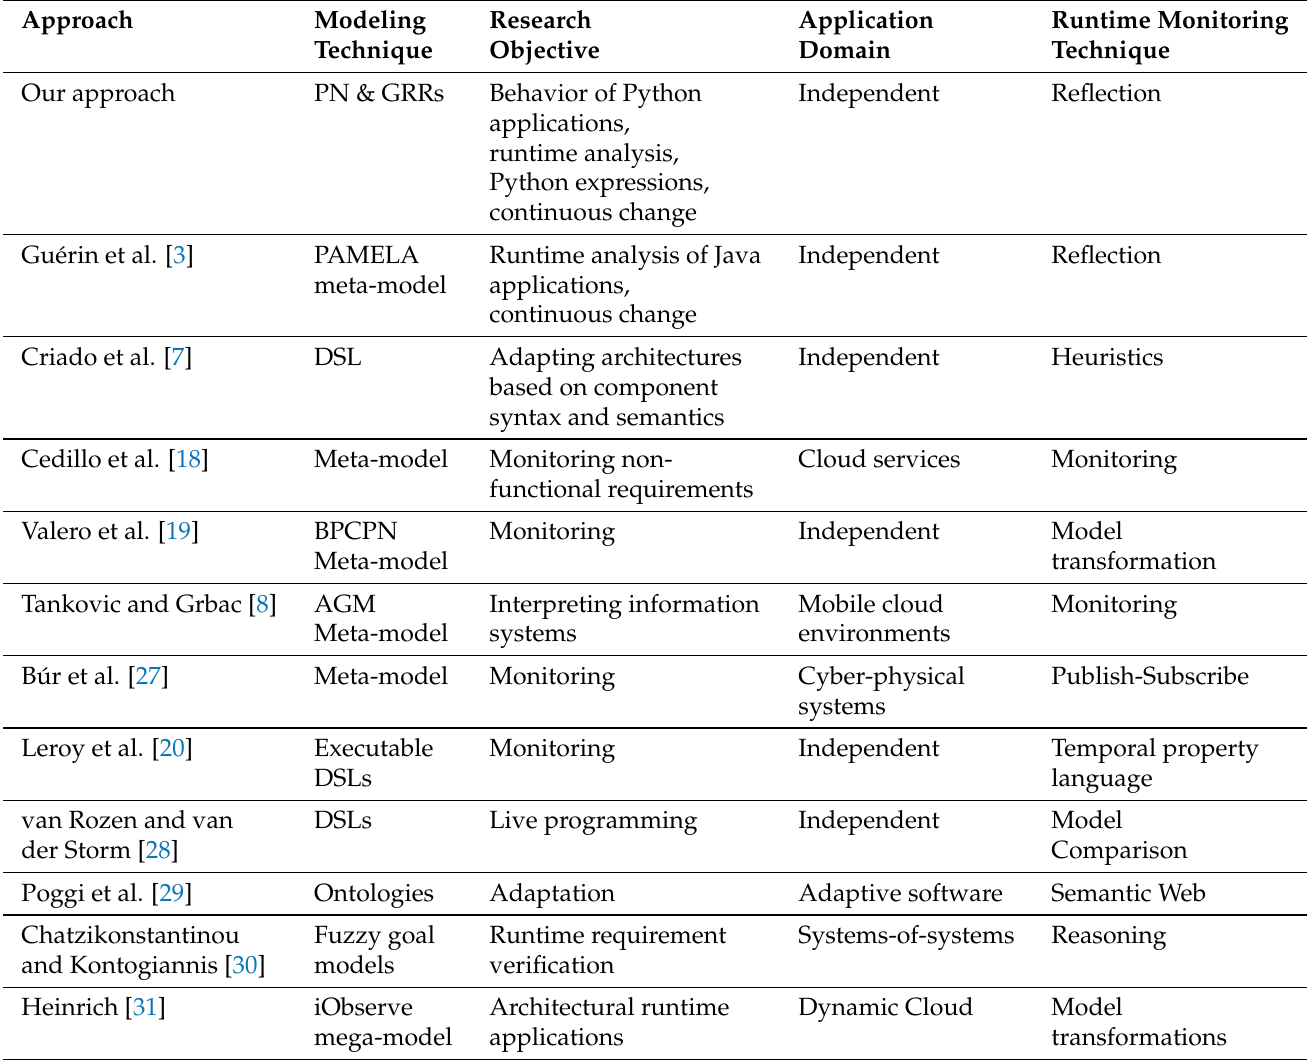
Table 6. Approach